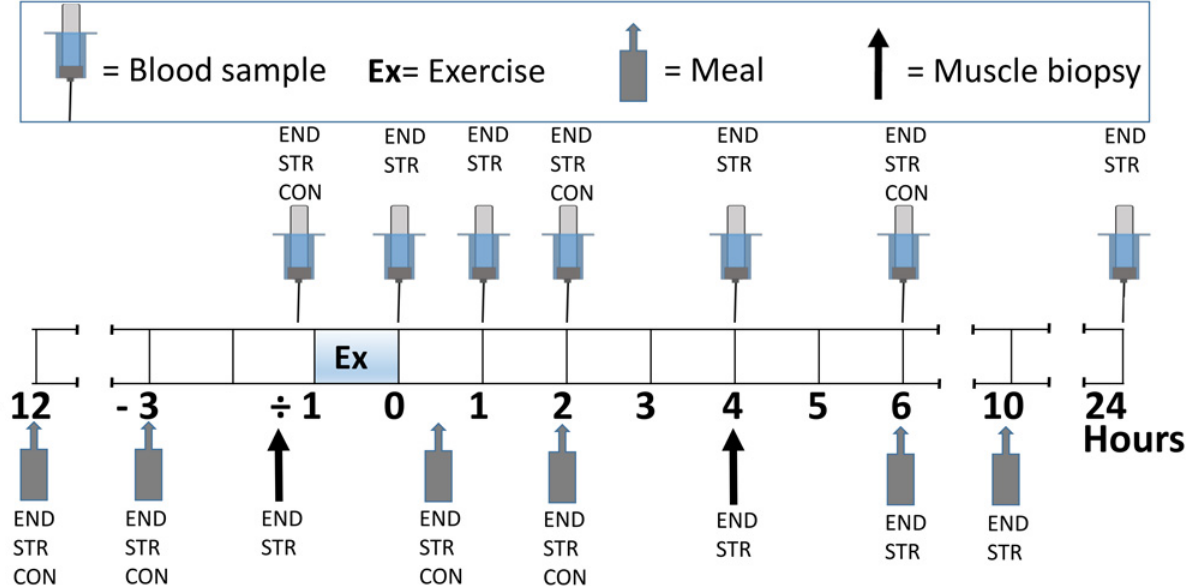
Fig 1. Schematic presentation of the protocol of the test days. The time line spans the period from the evening prior to exercise days (-12) to the subsequent morning to exercise days (24 hours subsequent to exercise). 0h = the end of the 60 minutes exercise sessions. There were three test days; one day with a session of intense endurance exercise (END), one day with a session of heavy strength training (STR) and one day without exercise (CON). CON was similarly structured as END and STR, except that no exercise was performed, no muscle biopsies were sampled, and blood samples were only sampled at-1h, 2h and